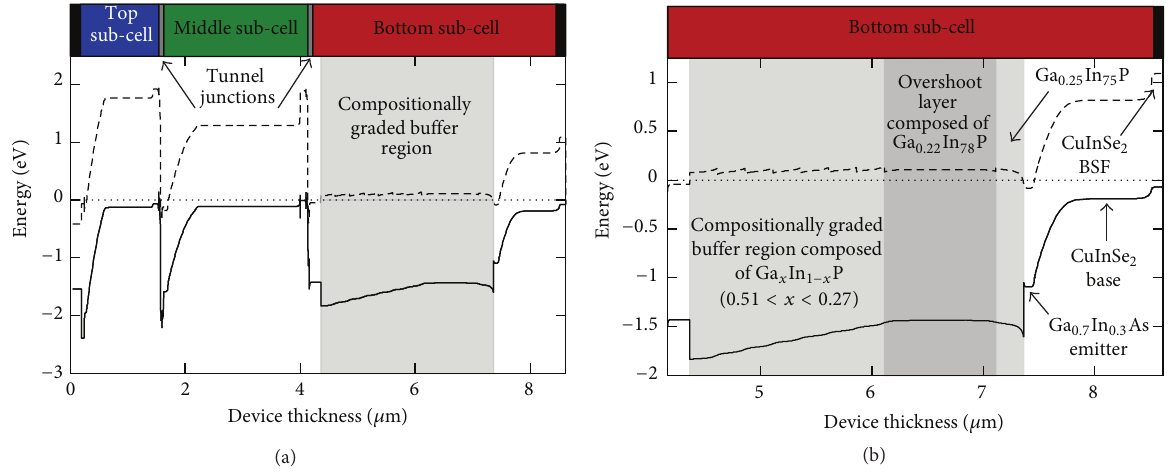
Figure 4: (a) Simulated energy band diagram of the GaInP/Ga(In)As/CuInSe 2 3J under illumination conditions and (b) a closeup of the energy band diagram at the compositionally graded buffer region composed of GaInP including the overshoot layer and the CuInSe 2 based bottom subcell including a highly doped CuInSe 2 back surface field (BSF).